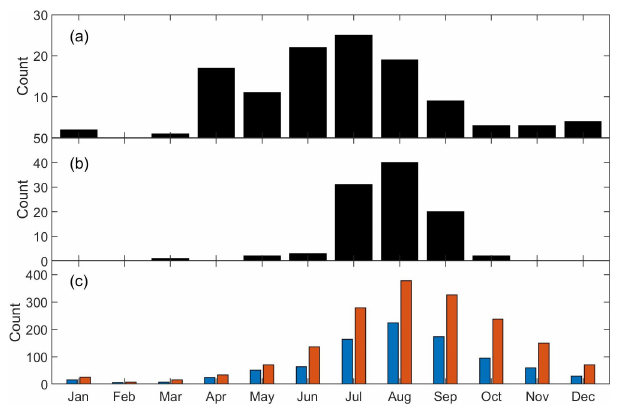
Figure 5. Statistics on TCs that struck China: (a) 0–1000CE; (b) 1000–1910CE; (c) 1945–2013CE. Blue bars indicate the ones that hit China; the red bars indicate the ones that hit the north- western Pacific Ocean